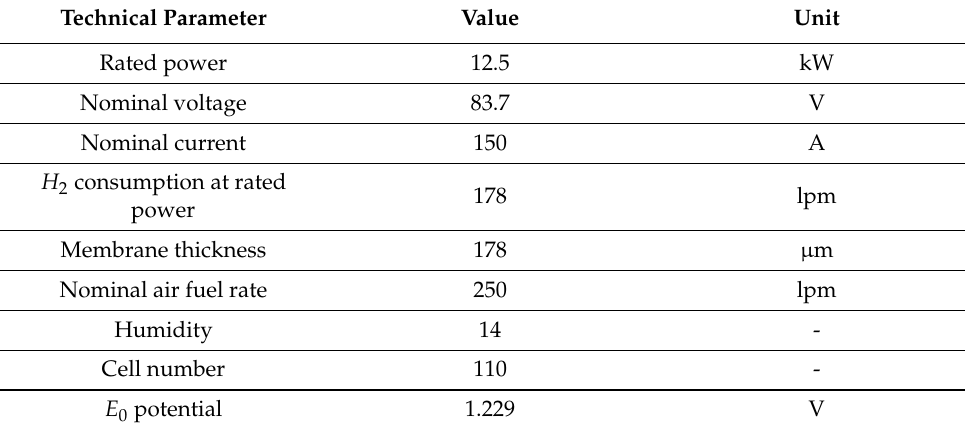
Table 4. Technical specifications of the PEM fuel